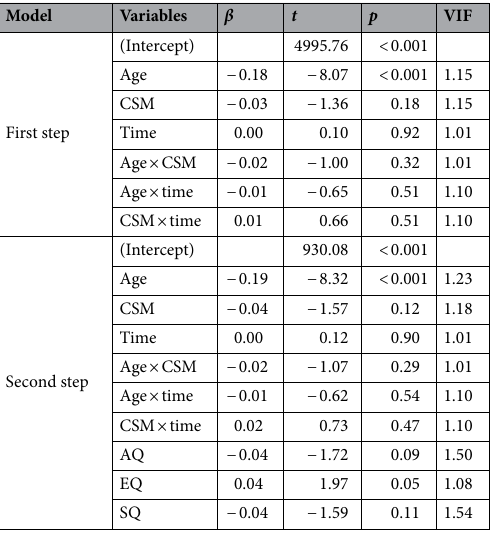
Table 6. Results for the multiple regression analysis for body temperature in Survey